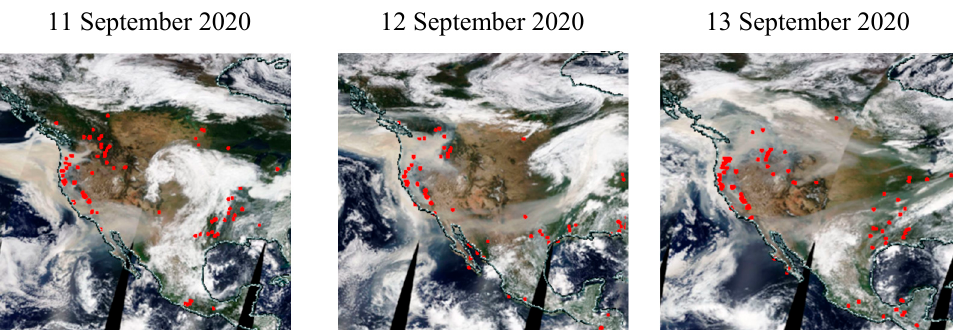
Figure 2. Color composite satellite images and hot spots (denoted by red dots) during the severe wildfires of western North America, 11–13 September 2020 (from Terra Moderate Resolution Imaging Spectrometer (TERRA/MODIS/MOD14)) [35].